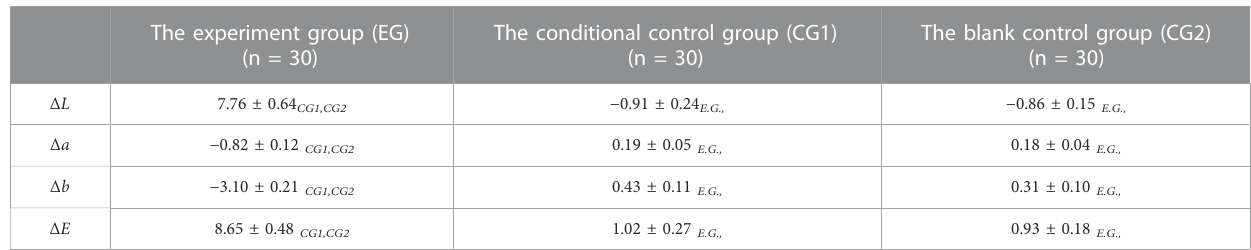
TABLE 1 The change of Δ L , Δ a , Δ b and Δ E within 40 days after bleaching. The experiment group (EG) (n = 30)